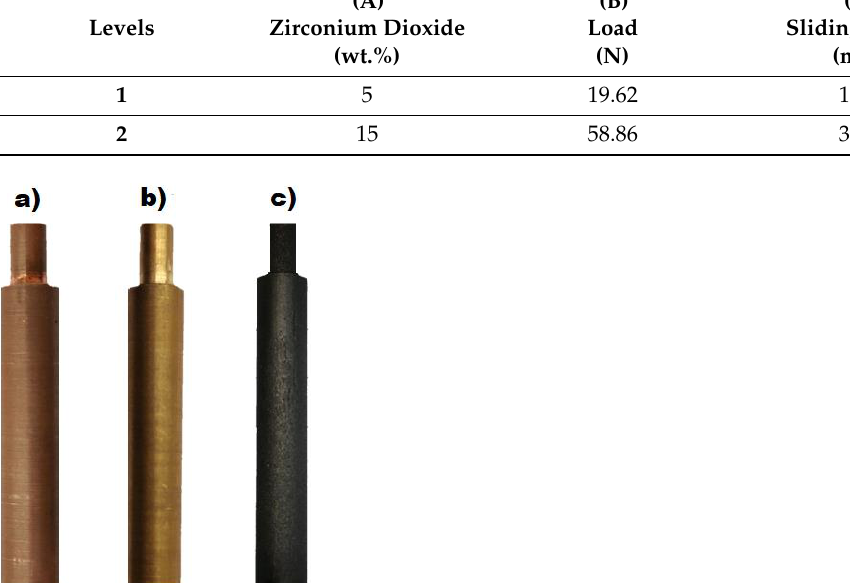
Figure 7. Electrodematerials: ( a ) brass, ( b ) copper, and ( c ) graphite.